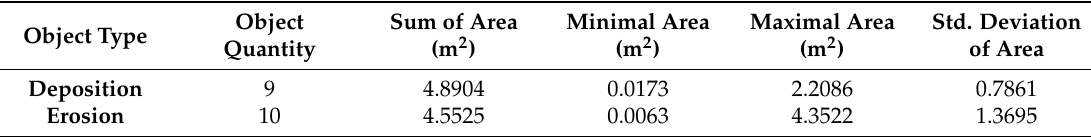
Table 2. Area Statistics of Erosional and Depositional